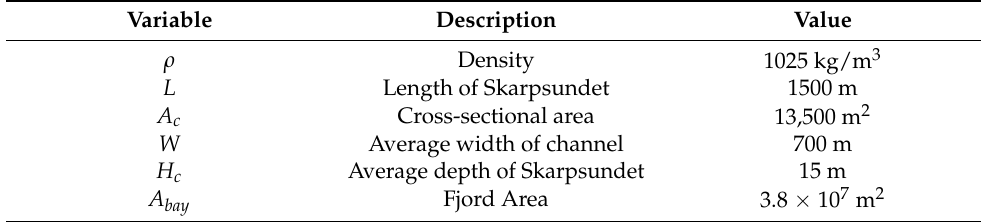
Figure 8. ( a ) Maps of Norway’s fjords Elsfjorden and Ranfjorden, with the Skarpsundet channel highlighted. ( b ) Bathymetry of the Skarpsundet channel and measurements station [31]. Table 2. Values for the Skarpsundet channel.